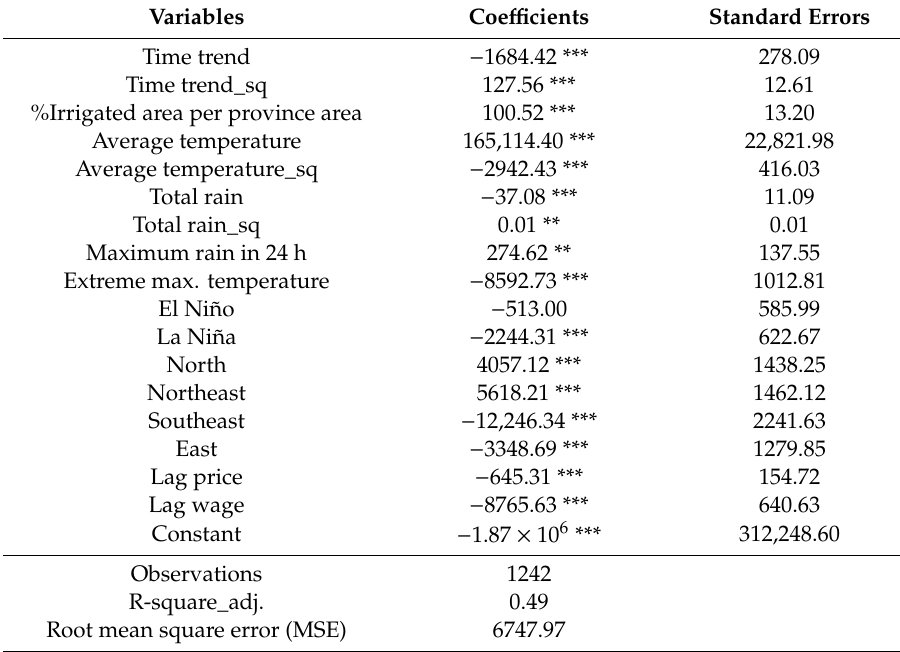
Table 2. Determinants of yield.